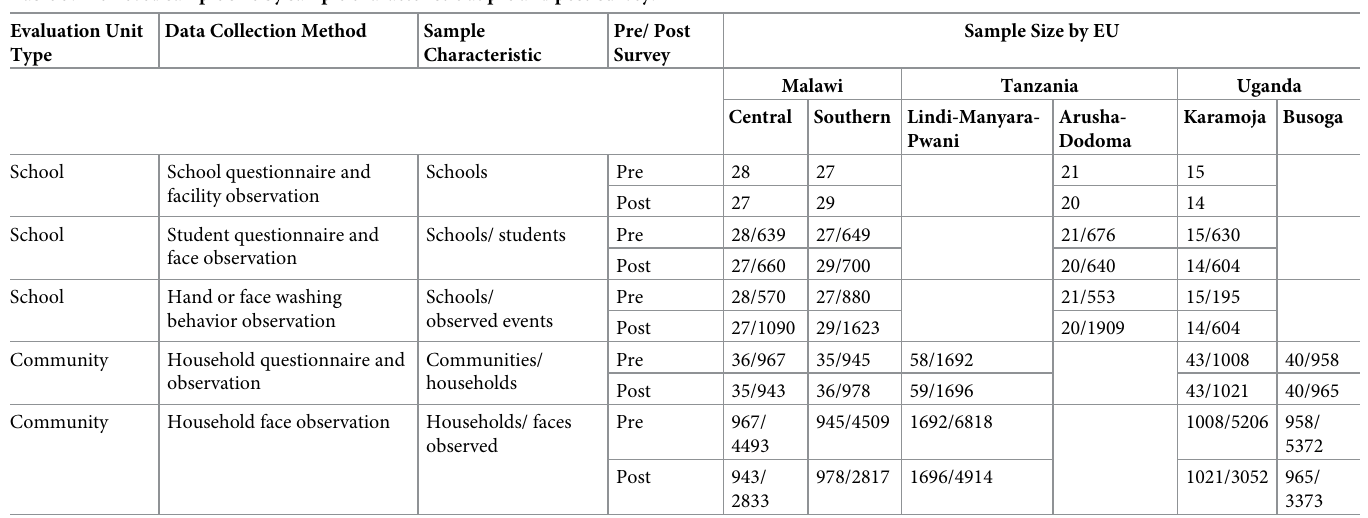
Table 3. Achieved sample size by sample characteristic at pre and post-survey.